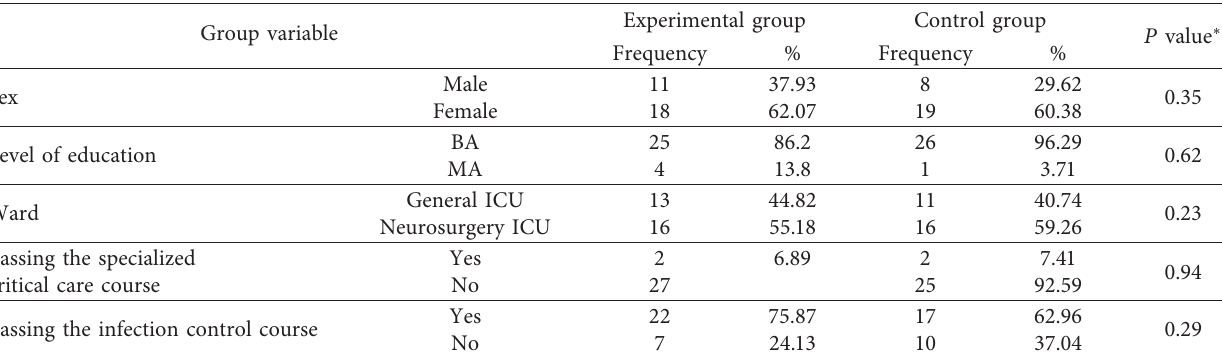
Table 2: Demographic characteristics of